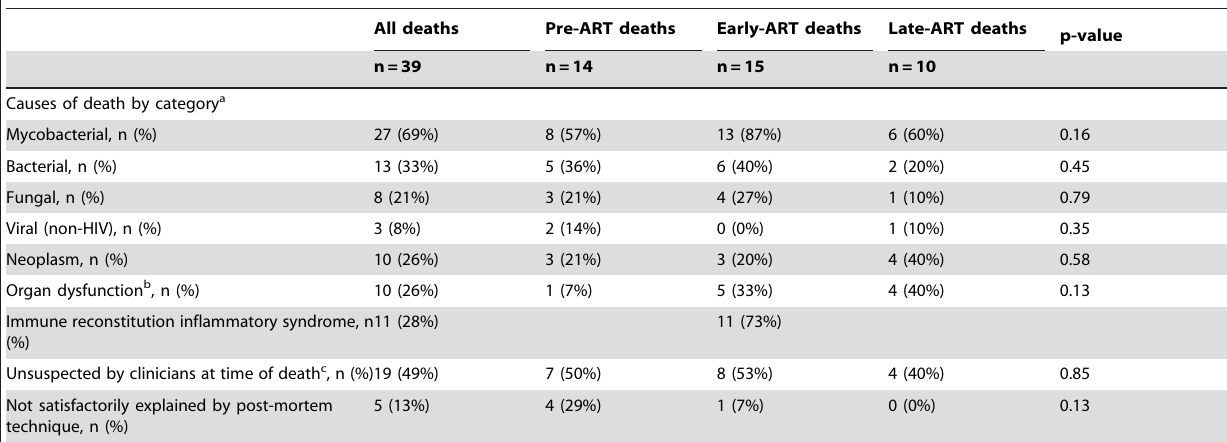
Table 3. Causes of death by